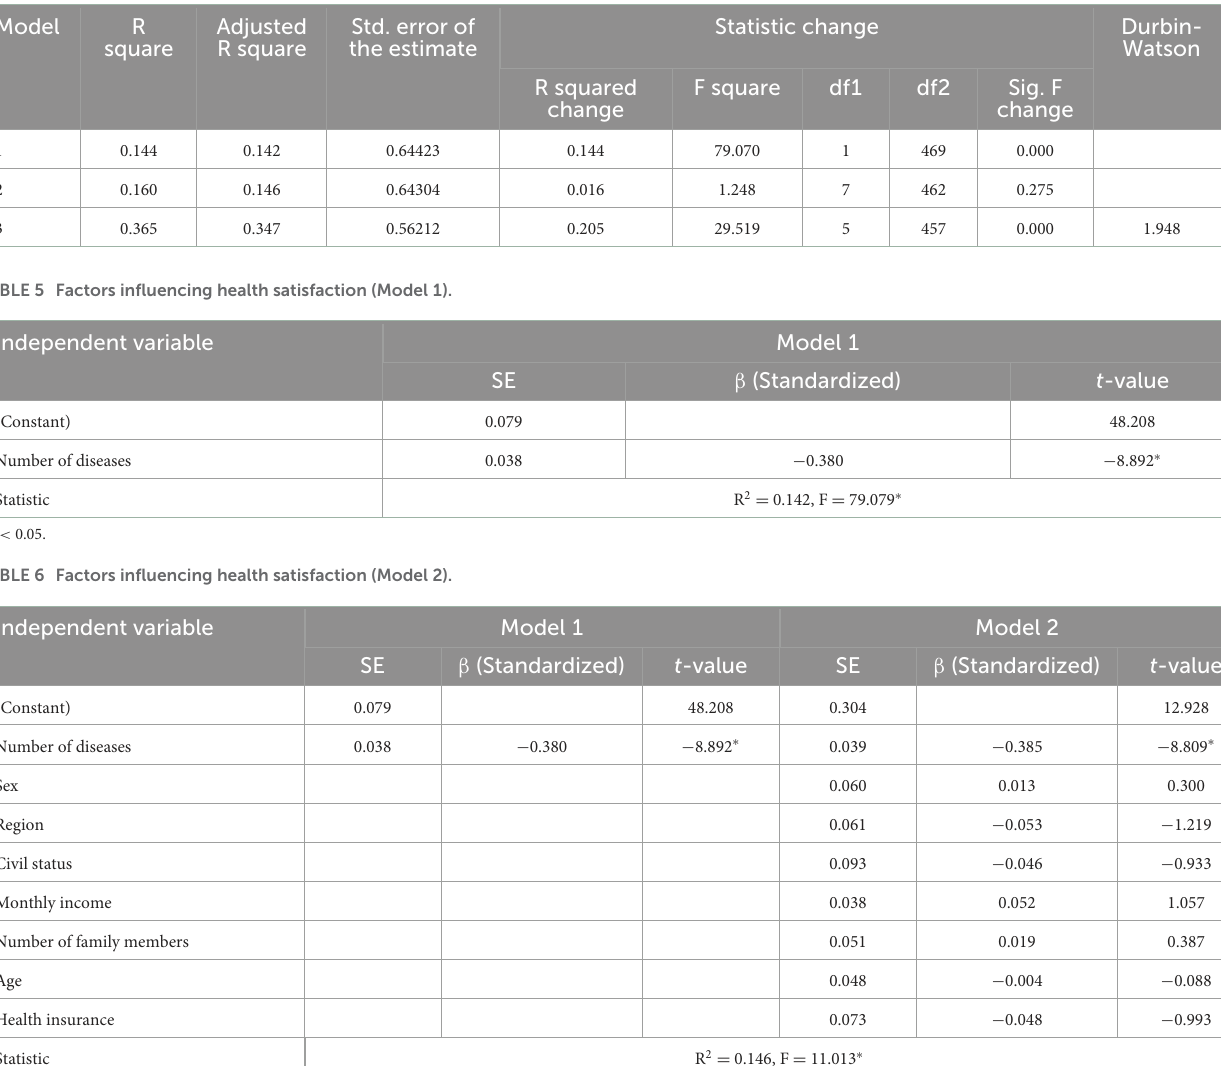
TABLE 4 Hierarchical multiple regression model summary.